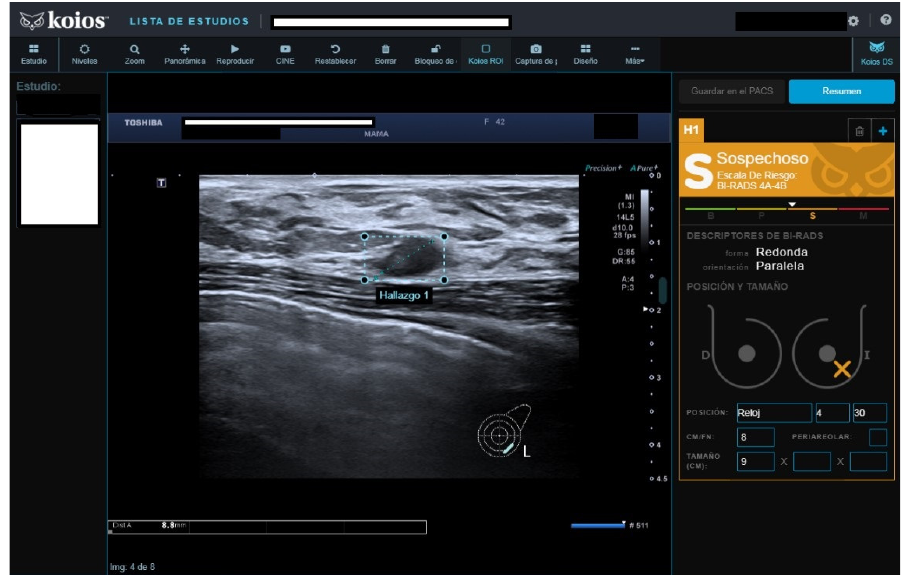
Figure 4. Nodule rated B3 by reader (no Doppler), KSS by KOIOS. Cytology reported grade 1 carci- noma. Biopsy confirmed invasive carcinoma.